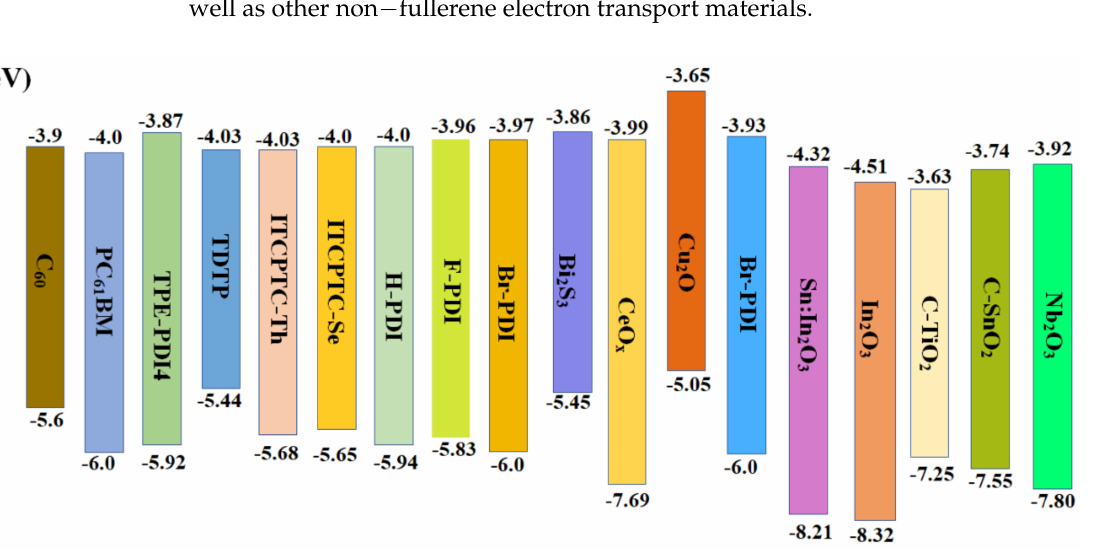
Figure 7. Energy levels of electron transport materials in inverted PSCs, including C 60 and its derivatives as well as other electron transport